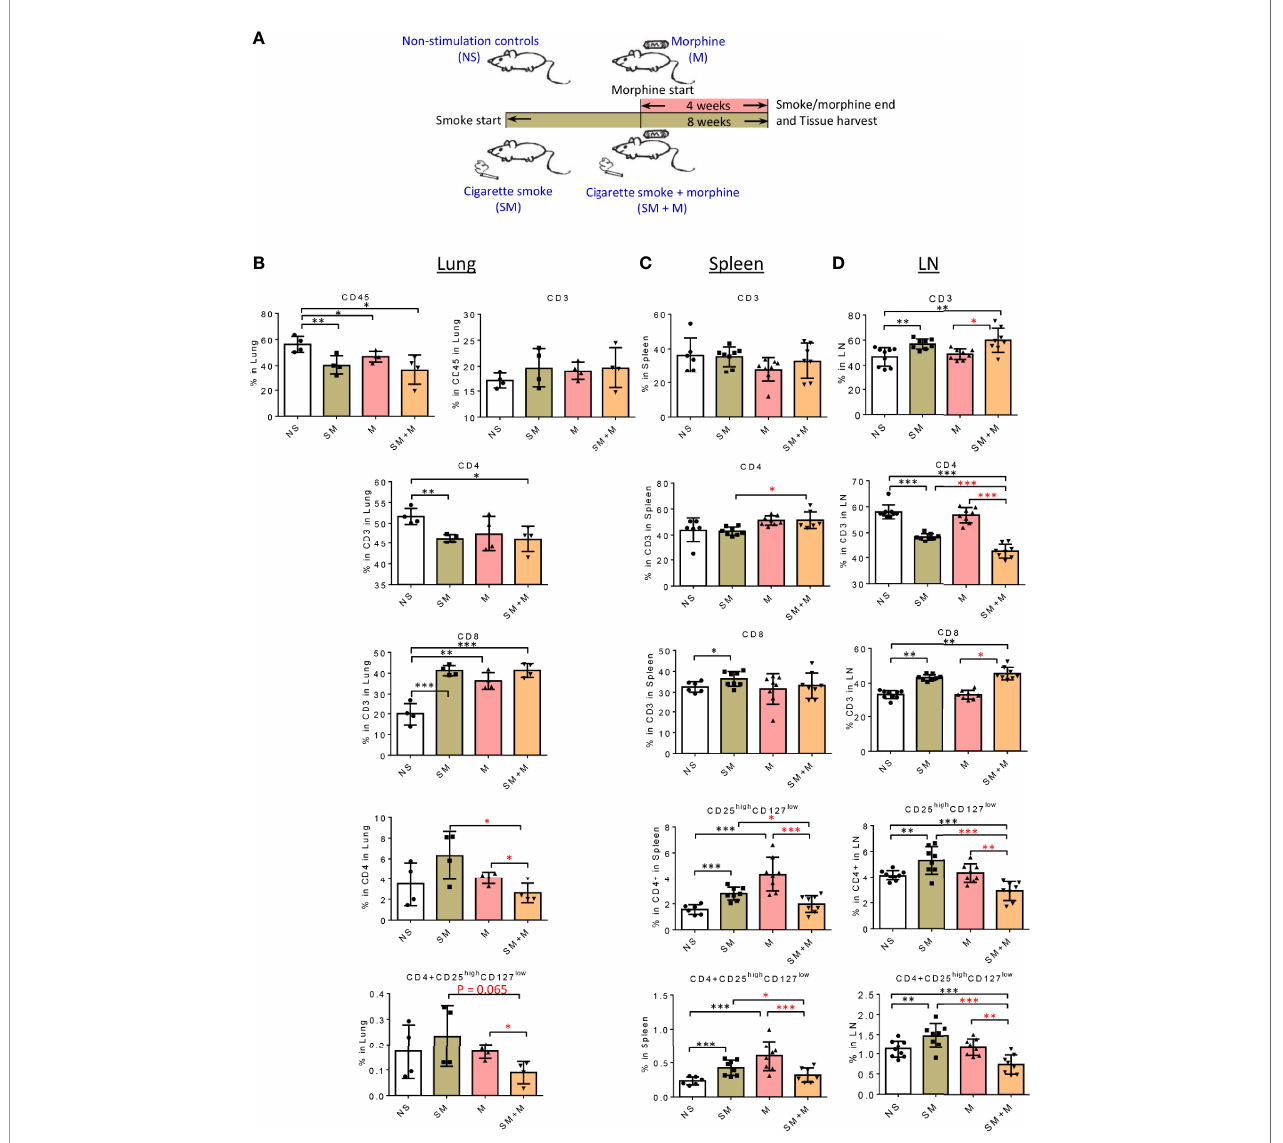
FIGURE 1 | SM + M treatment decreased CD4+CD25 high CD127 low Treg cells in the lung and lymph nodes. (A) Schematic representation of stimulations in four groups of male mice: 1) non-stimulation controls (NS); 2) smoking (SM); 3) morphine (M); and 4) smoking plus morphine (SM + M). B-D. The fl ow cytometry detections were performed for analyzing the populations of CD45 (lung only), CD3, CD4, CD8, CD25 high CD127 low Treg in (B) lung (n = 4), (C) spleen, and (D) lymph node (LN) (n = 8). Bar graphs indicate the percentage of each subset in its parent population. Percentage of CD25 high CD127 low Treg in all cells from lung, spleen and LN were calculated and showed in the last row. (T-test, *p < 0.05, **p < 0.01, ***p < 0.001, * in black represents the difference between SM, M or SM+M and NS control, * in red represents the difference between SM+M and SM or